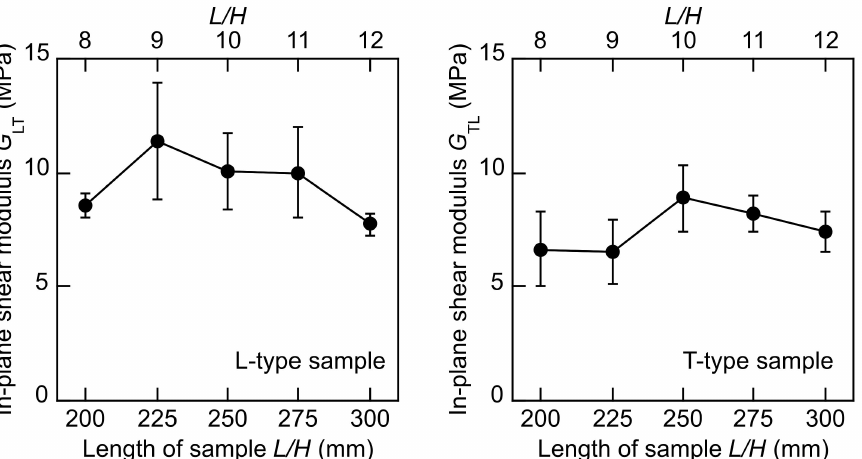
Figure 7. G LT – L, G LT – L/H, G TL – L , and G TL – L/H relations determined by flexural vibration tests. Results = average ± standard deviations.